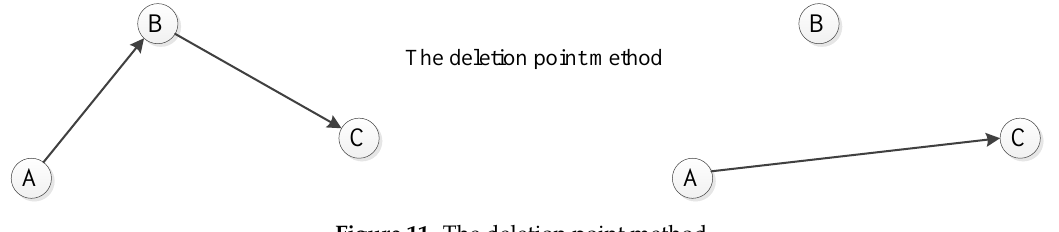
Figure 11. The deletion point method.